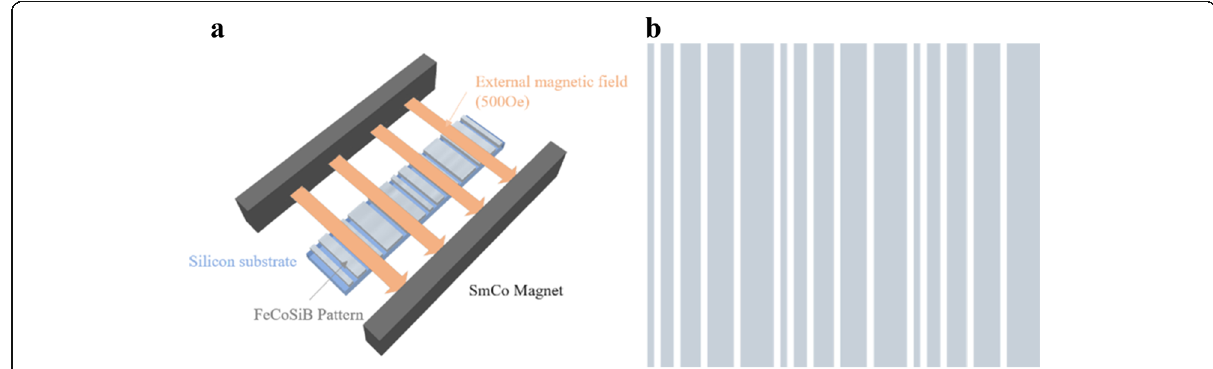
Fig. 1 The scheme of the external induced magnetic field during deposition ( a ) and combined stripes patterned magnetic films ( b ). The width of each stripe were 5, 10, 15, 20, and 25 μ m, respectively. The width of gap between two stripes was fixed at 5 μ m. Lift off process was done after deposition to expose the final structure of